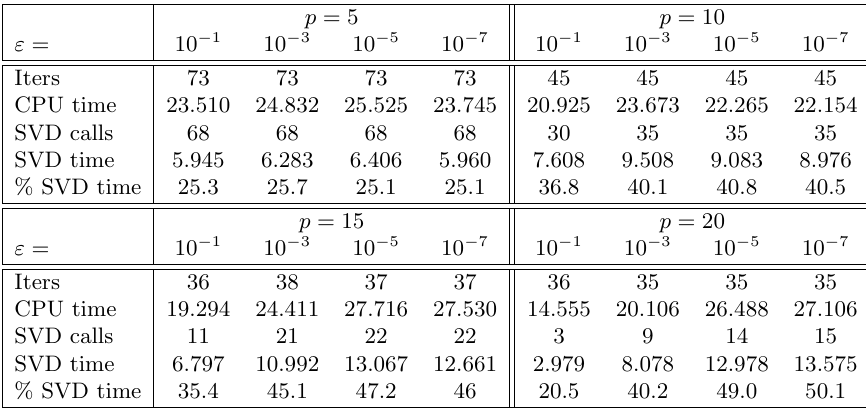
Table 7. Performance of the DBRR method for Problem 4.